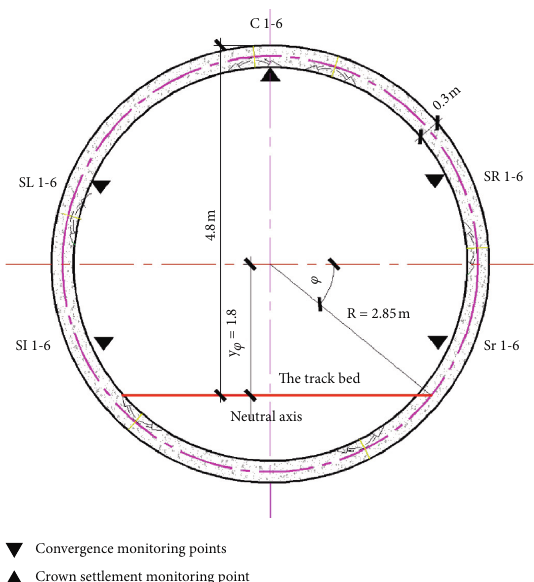
Figure 2: Cross section of monitoring points layout on the existing tunnel